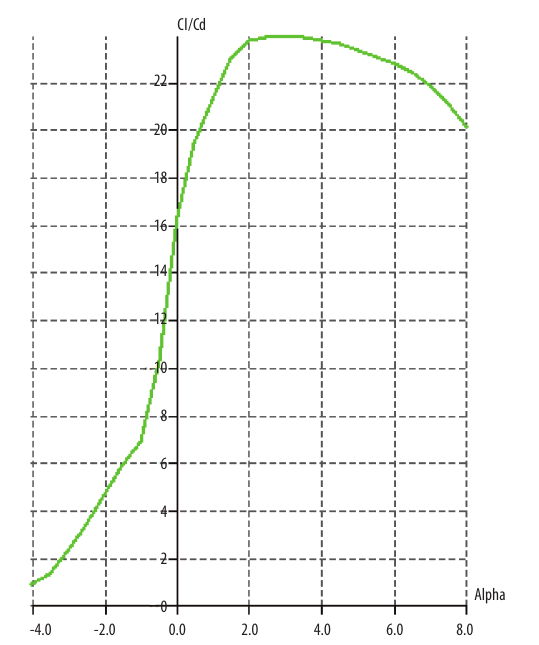
Fig. 5. Dependence of quality factor on angle of